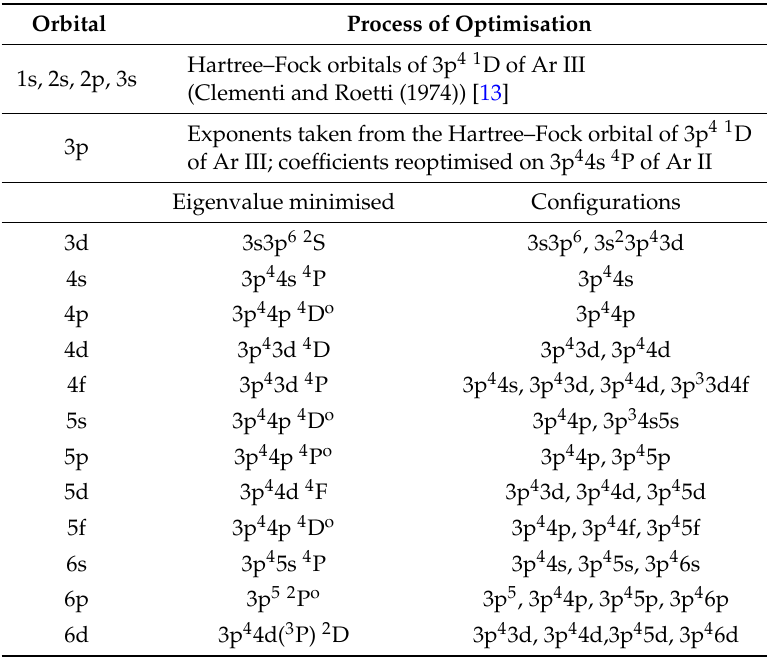
Table 1. Method of determining the radial